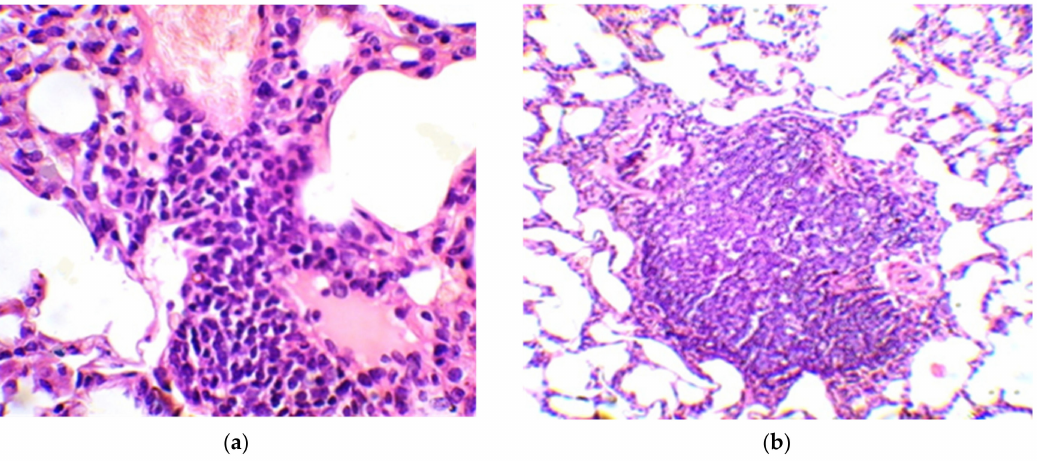
Figure 5. Lung of a guinea pig immunized with BCG vaccine. ( a ) There are few perivascular couplings that show no signs of lymphatic follicle formation (magnification of 200 × ). ( b ) There is a large lymphatic follicle located between the bronchus and artery (magnification of 50 ×